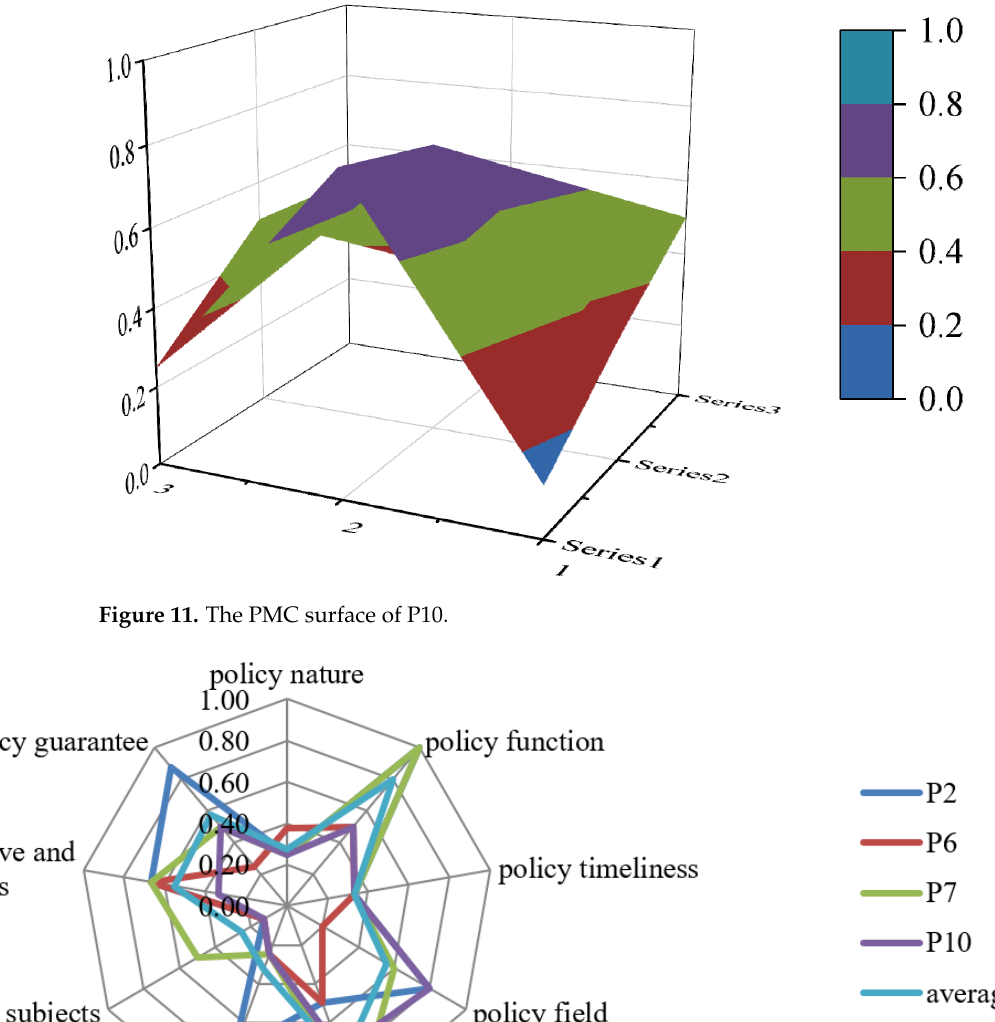
Figure 10. The PMC surface of P9.